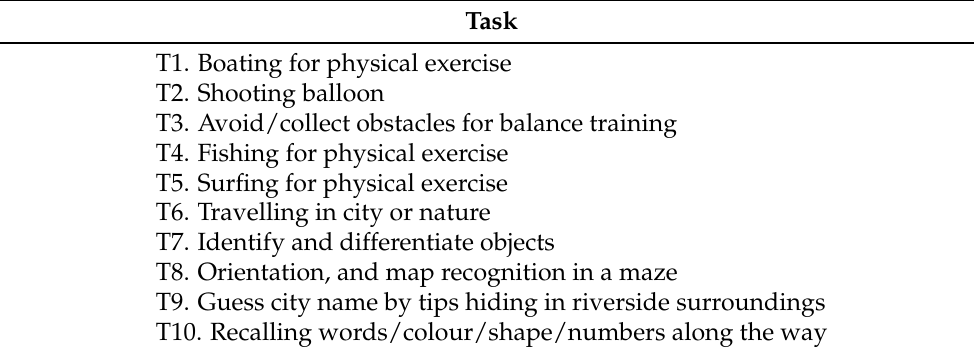
Table 3. Game tasks in VRrowing